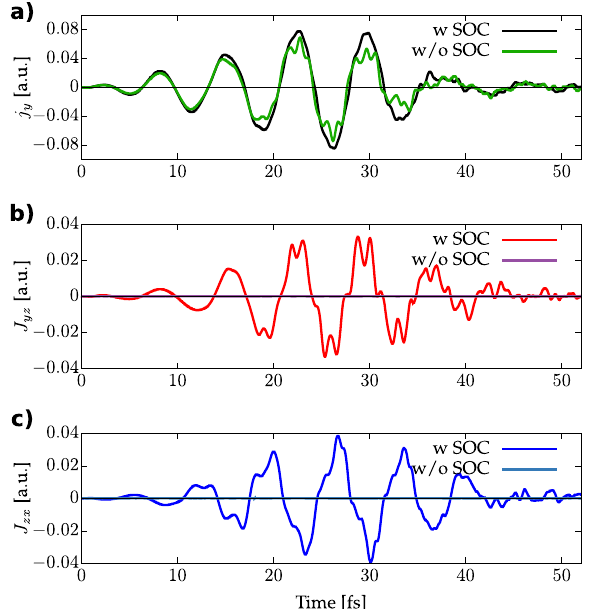
Fig. 4 Effect of SOC on the charge and spin currents. a Calculated charge current along the y axis, for a RHS circularly-polarized driver in the y − z plane with and without SOC. b , c Show respectively the J J yz and zx components of the corresponding spin current. See the main text for more